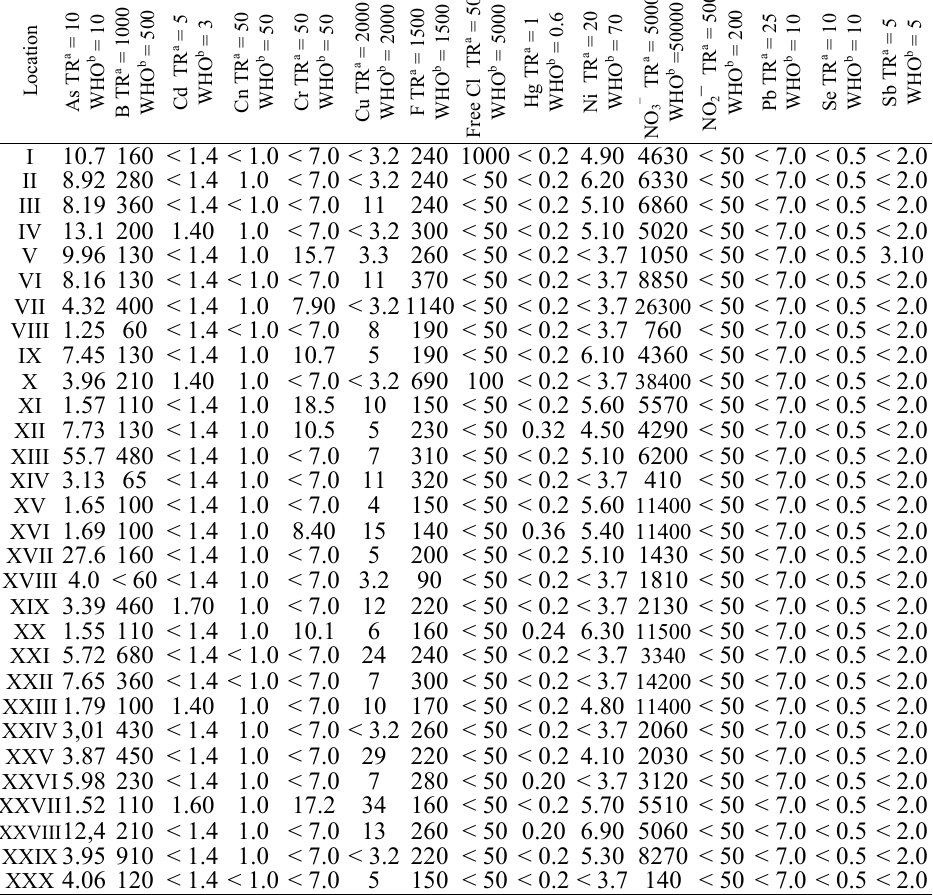
Guide values established by Turkish legislation for drinking water 11 . b Guideline values established by the World Health Organization for drinking water 1